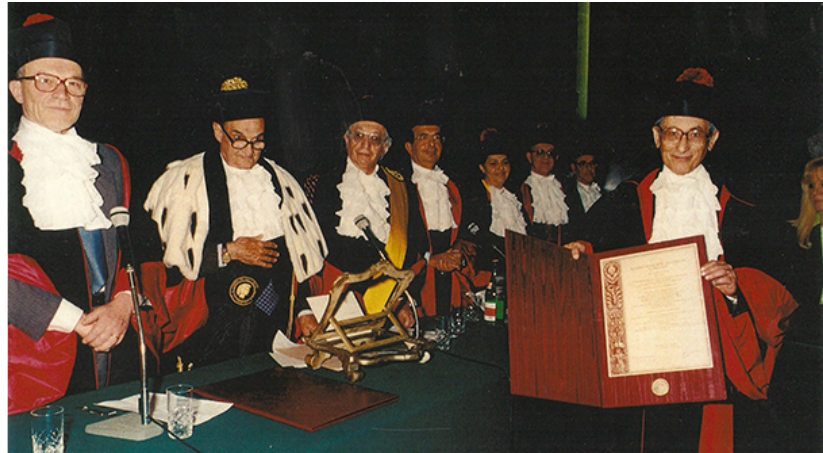
Figure 6: Herman Chernoff receives a Laurea honoris causa from La Sapienza (University of Rome) in 1996. Giorgio Dall’Aglio is the first standing on the